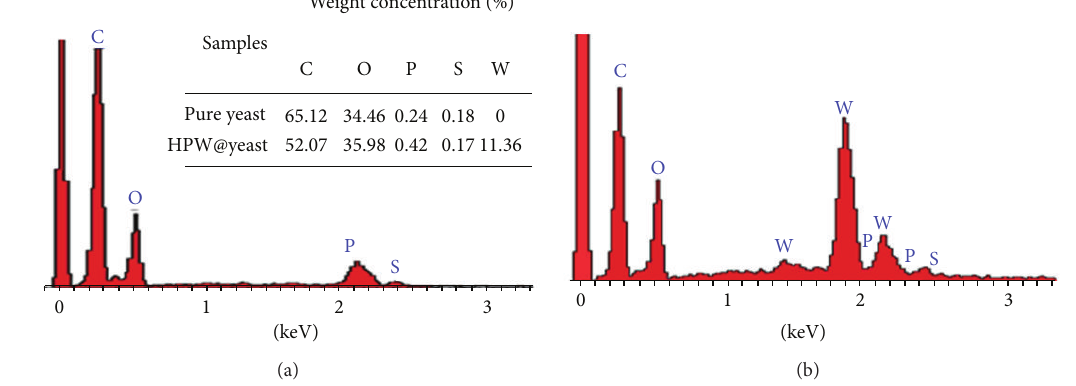
Figure 2: EDS spectra of (a) bare yeast and (b) HPW@yeast samples.